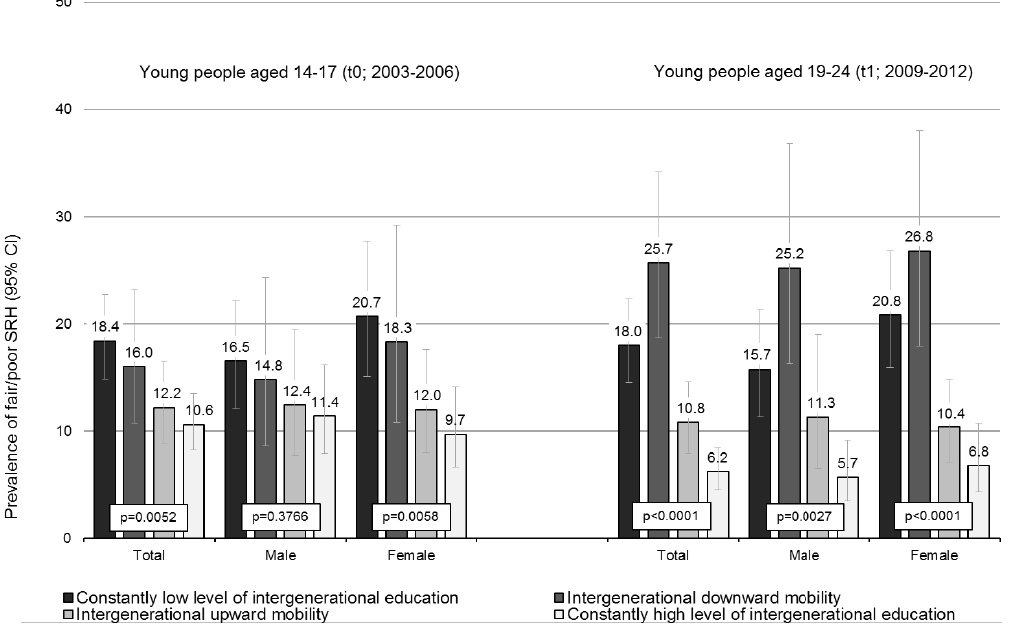
Figure 1. Proportions of fair/poor SRH during adolescence (t0) and young adulthood (t1) regarding intergenerational educational pathways (t1); p -values by Pearson’s Chi-square test.